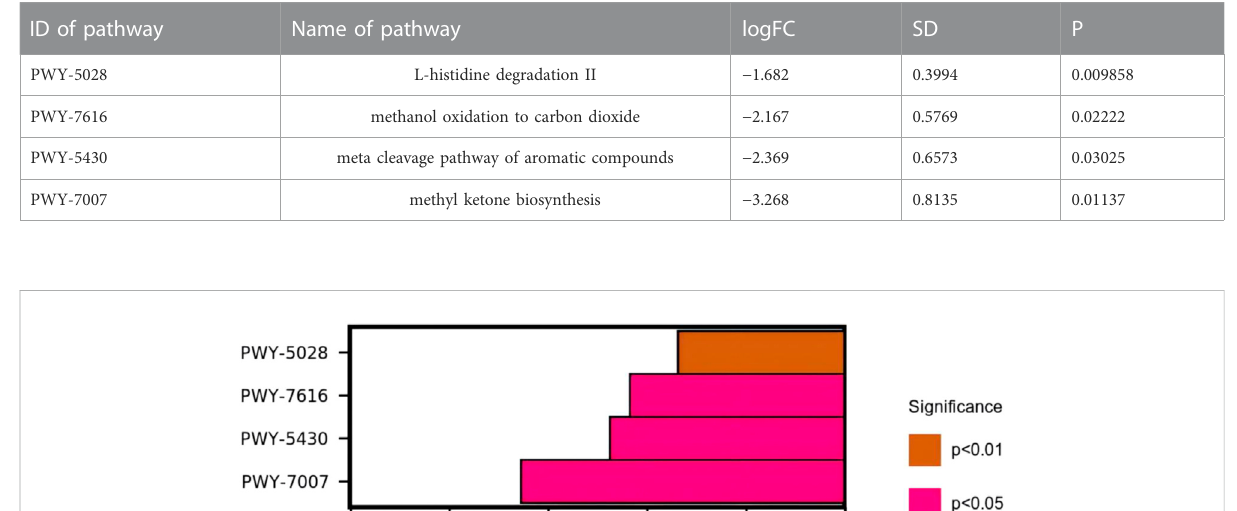
TABLE 3 Analysis of metabolic pathway differences of intestinal micro fl ora. ID of pathway